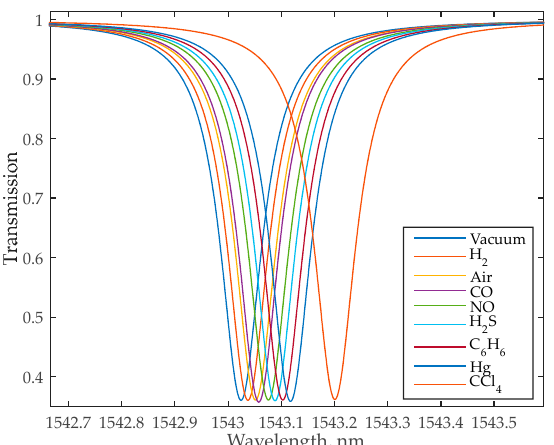
Figure 7. Transmission spectrum of the MRR for different ambient gases.